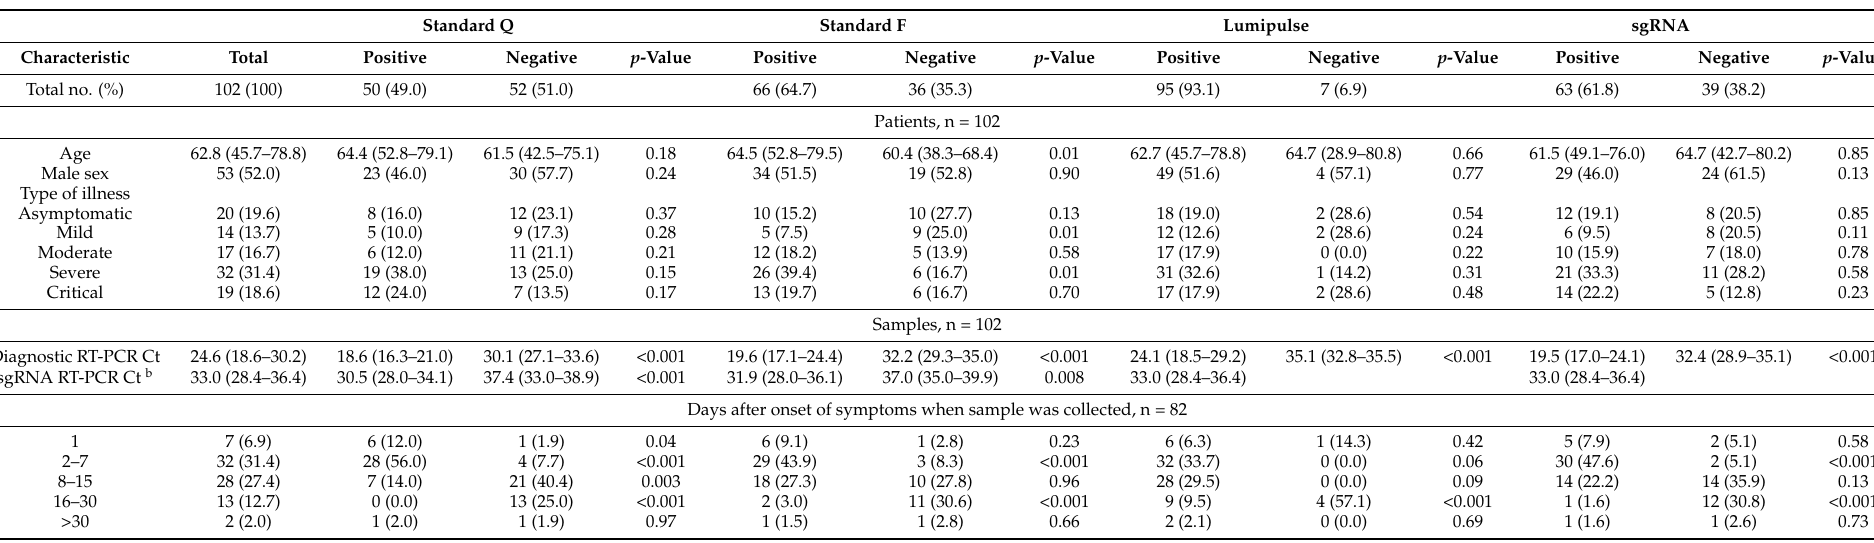
Table 1. Demographic and clinical characteristics of COVID-19 patients who had NPS samples analyzed for SARS-CoV-2 antigen and sgRNA a